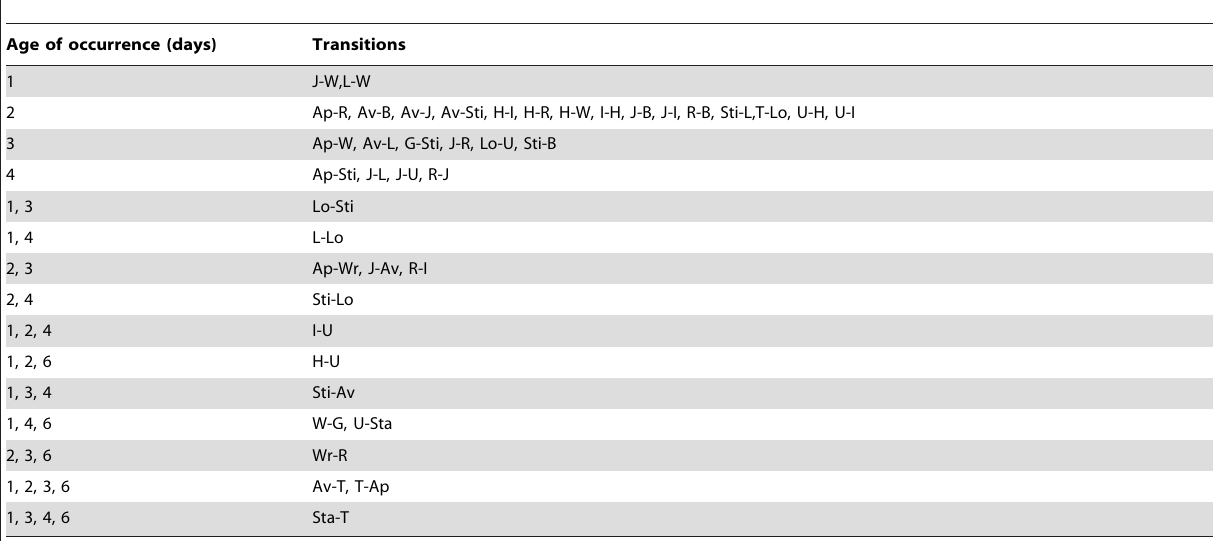
Age of occurrence